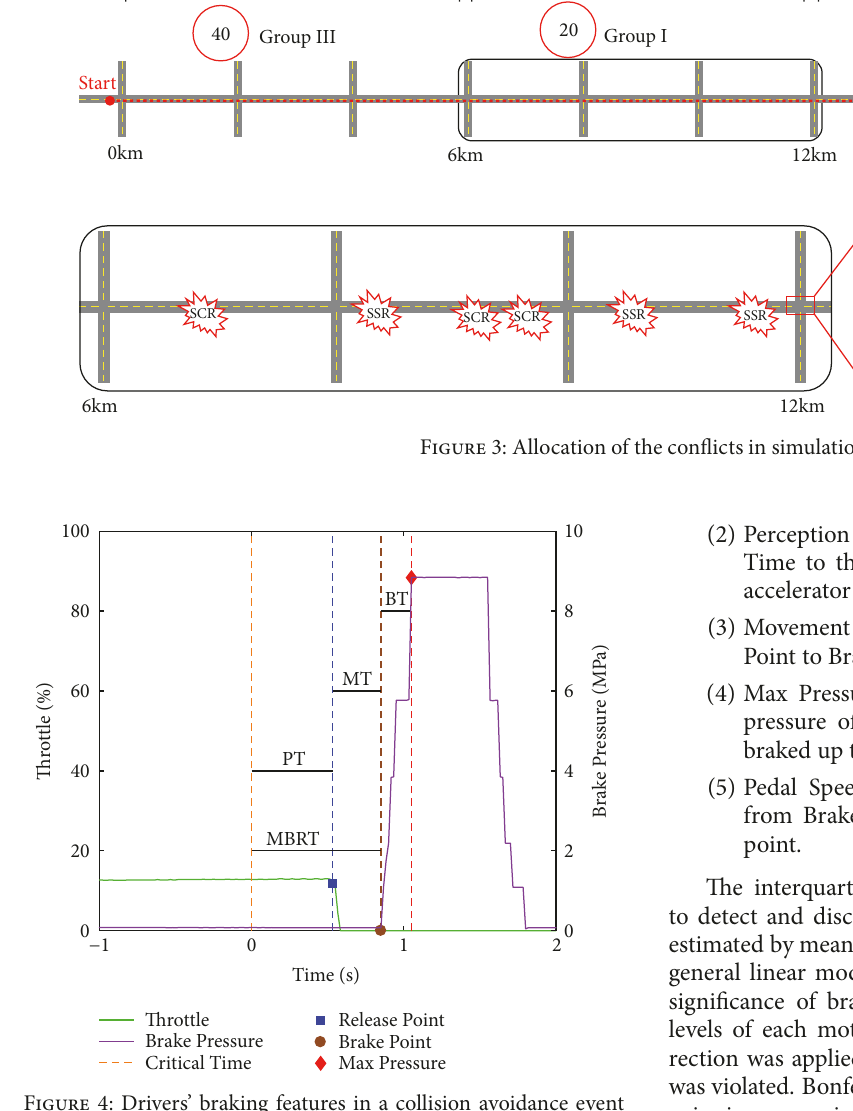
Figure 4: Drivers’ braking features in a collision avoidance event